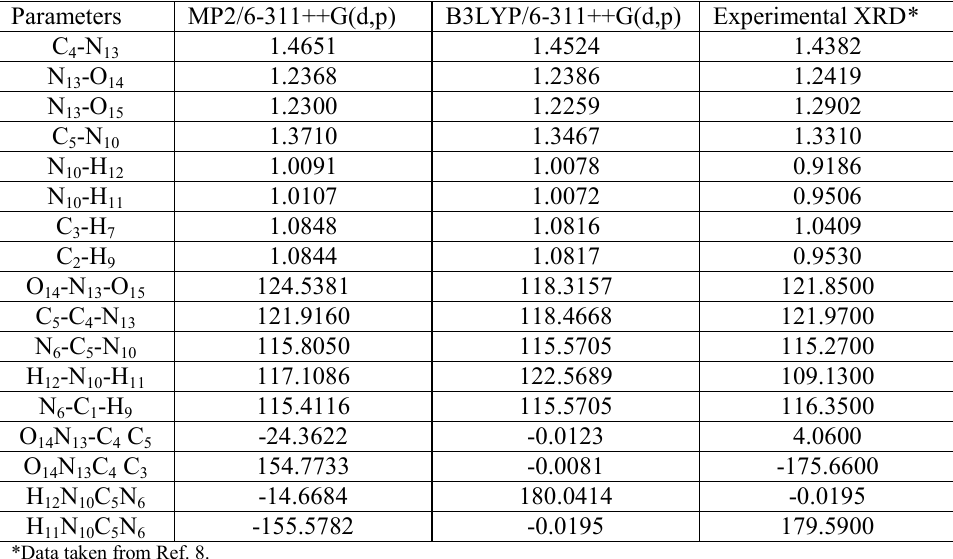
Table 1 . Selected geometrical parameters optimized in ANP (bond length (Å), bond angle (°) and dihedral angle (°).